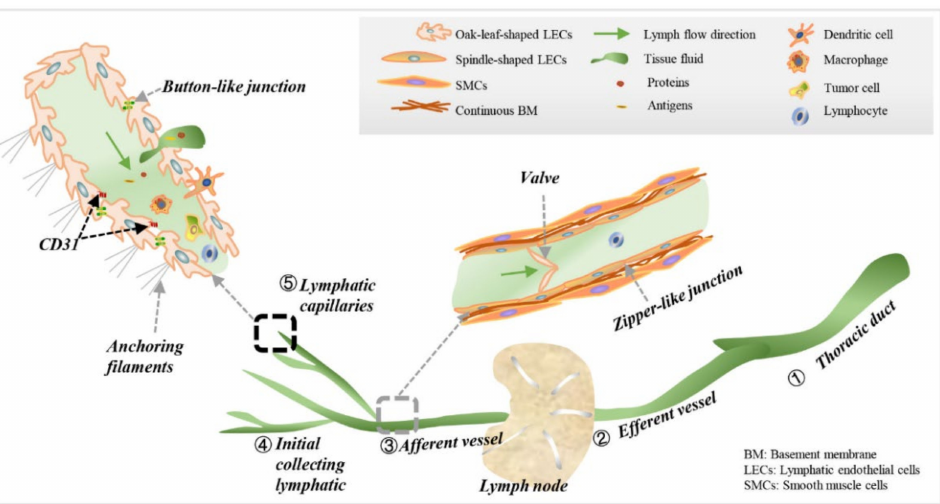
Figure 1. Tree-shaped lymphatics are composed of lymphatic capillaries, initial collecting lymphatics, afferent and efferent lymphatics, and the thoracic duct. Lymphatic capillaries are expanded blind- ended irregular lumens lined with a single layer of oak-leaf-shaped LECs without pericytes or SMCs, and anchored to the surrounding tissue via anchoring filaments. There is no BM around the capillaries. Overlapping flaps between adjacent oak-leaf-shaped LECs are anchored on the sides by discontinuous button-like junctions. CD31 is located at the tip of flaps, where there is a lack of buttons. By contrast, collecting lymphatics are lined with spindle-shaped LECs anchored by zipper-like junctions and covered with continuous BM and SMCs. Gaps at overlapping flaps in lymphatic capillaries are lymph inlets, while valves in collecting lymphatics are backflow-prevention